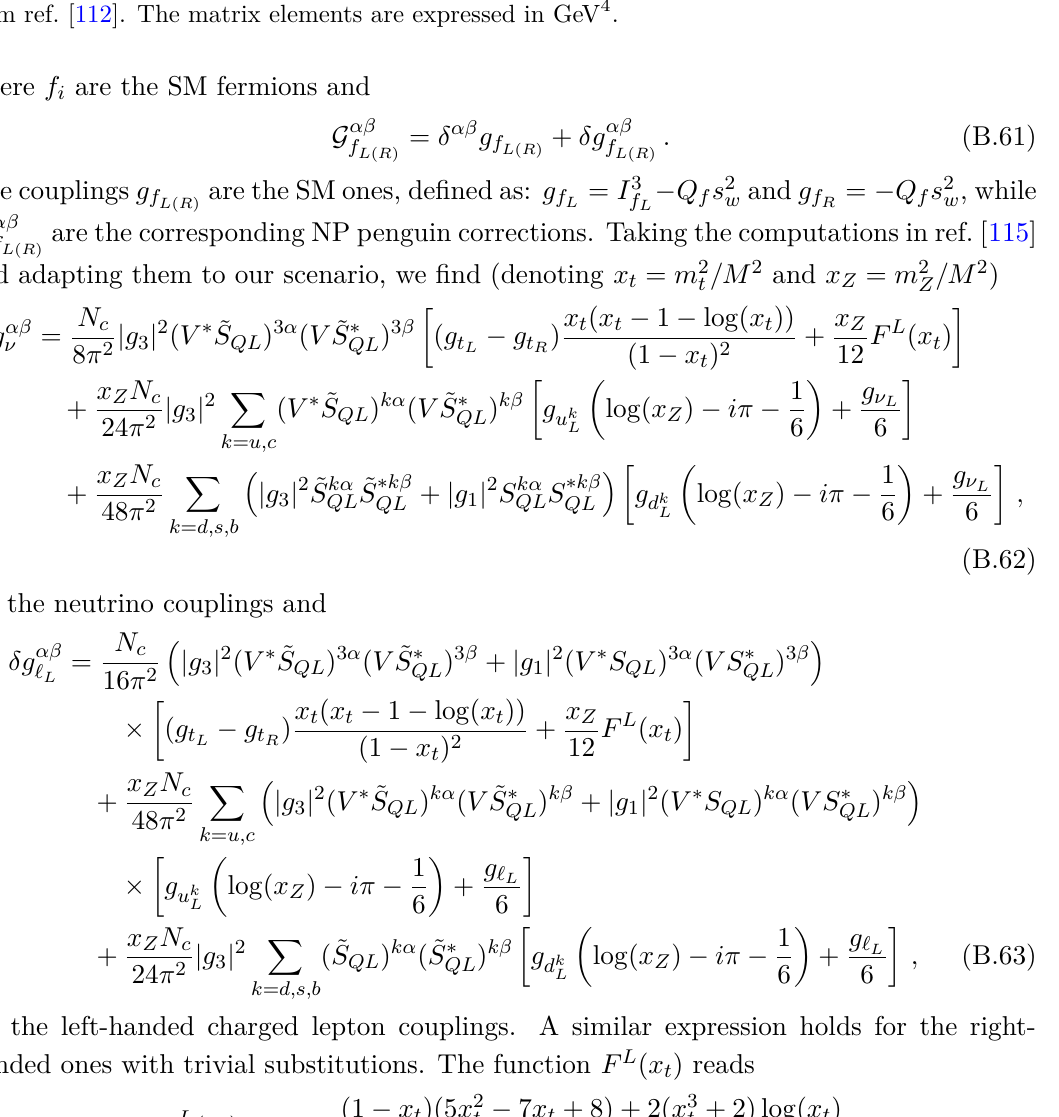
Table 4 . Values for the hadronic matrix elements in ∆ C = 2 processes at the scale µ = 3 GeV from ref. [112]. The matrix elements are expressed in GeV 4